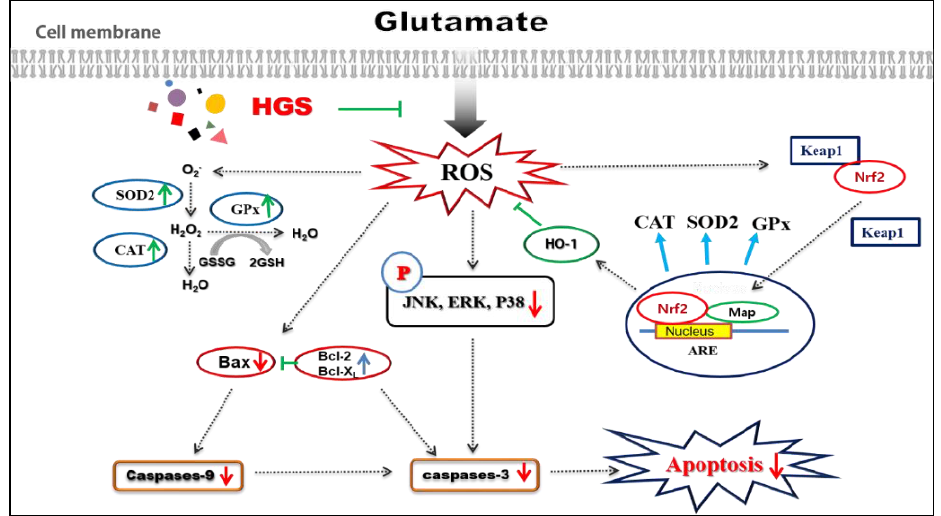
Figure 7. Schematic of the mechanisms of the amelioration by HCS of glutamate-induced neuronal cell death.